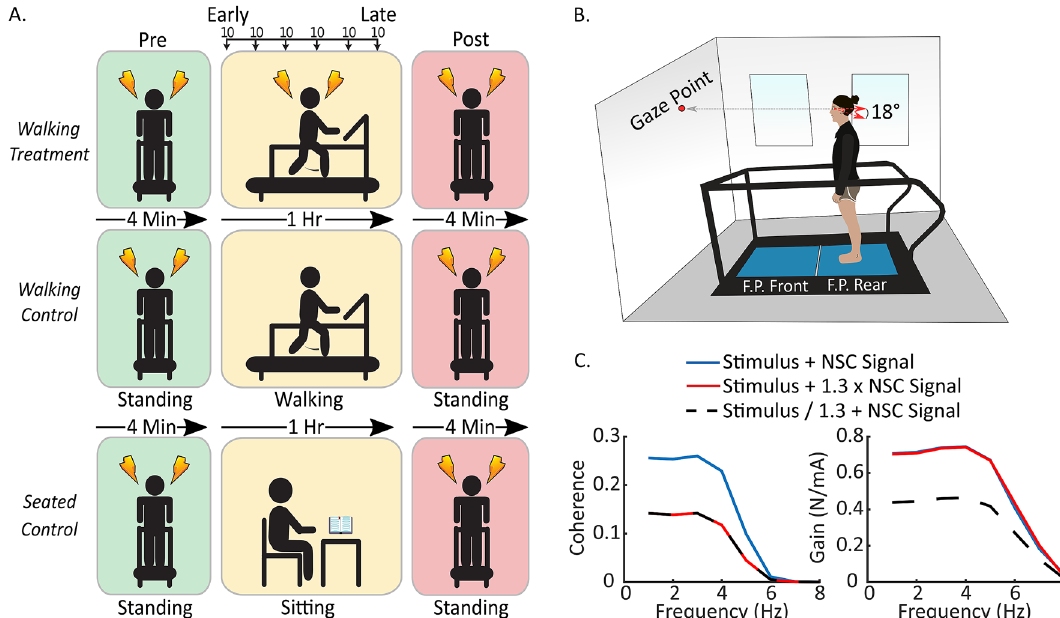
Figure 1. Experimental protocol completed by the three procedural groups, experimental setup, and predicted results. ( A ) Each group stood for 4 min at the start and end of the experiment while receiving galvanic vestibular stimulation. Between the two 4-min standing periods, the Walking Treatment group walked for six consecutive 10-min periods while receiving stimulation, the Walking Control group walked for 60 min without stimulation, and the Seated Control group sat and read for 60 min without stimulation. ( B ) Participants stood or walked on the rear force plate of a tandem two-belt instrumented treadmill. They fixated at a point on the wall to maintain their head orientation at Reid’s plane tilted 18° nose up. ( C ) Simulation of likely potential outcomes. The left panel illustrates changes in coherence relative to baseline (blue line) when non-stimulus correlated (NSC)